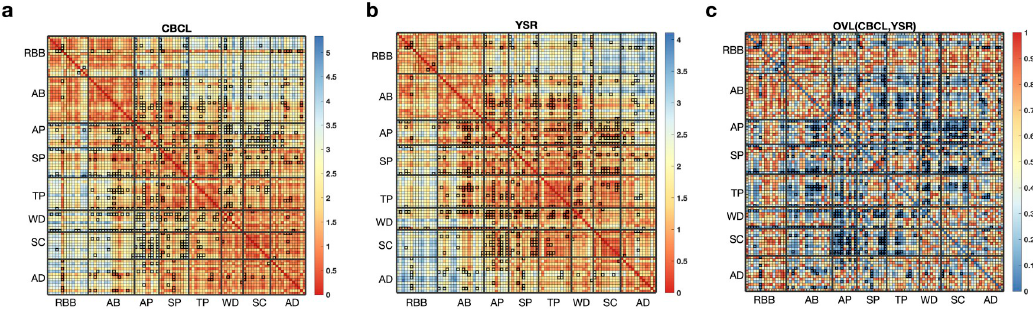
Fig 4. Item-item distance heatmaps of the CBCL and YSR, and an overlapped portion heatmap between the CBCL and YSR. (a) displays the distance heatmap between pairs of item latent positions in the CBCL ( D CBCL ) and (b) displays that in the YSR ( D YSR ). ij ij and D YSR distributions for all item pairs. The item pair with a large (c) shows the heatmap of the overlapped portion between D CBCL ij ij overlapped portion means the perceived relation of that item pair is similar in both informants, while the item pair with a small overlapped portion means their relationship is perceived as different. The item pair with a large overlapped portion is colored with red, and the item pair with a small overlapped portion is colored with blue. The item pairs with overlapped portions less than 0.05 are marked with bold edges. About 9% of the pairs had overlapping portions of less than 0.05, and most of these pairs exist between different item syndromes (off-diagonal blocks), related to attention (AP), social (SP), and thought (TP)